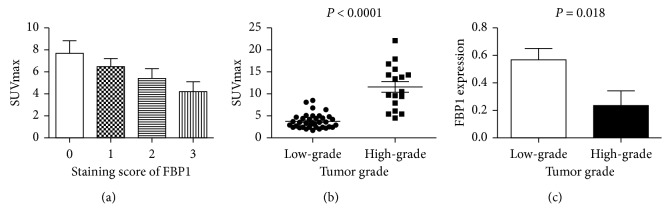
The relationship between FBP1 expression, SUVmax, and tumor grade in patients with ccRCC. (a) The relationship between SUVmax and the staining score of FBP1 in ccRCC. When the score of FBP1 staining was 0, 1, 2, or 3, SUVmax of ccRCC was 7.7 ± 5.8, 6.5 ± 1.3, 5.4 ± 2.8, and 4.2 ± 3.2, respectively. (b) SUVmax analysis in high-grade ccRCC and low-grade ccRCC. SUVmax was higher in patients with high-grade ccRCC (mean, 11.6 ± 5.0) than in those with low-grade ccRCC (mean, 3.8 ± 1.6, P < 0.001). (c) FBP1 expression levels in patients with high-grade ccRCC and low-grade ccRCC. FBP1 expression was significantly lower in patients with high-grade ccRCC (mean, 0.23 ± 0.1) than in those with low-grade ccRCC (mean, 0.57 ± 0.08; P=0.018).